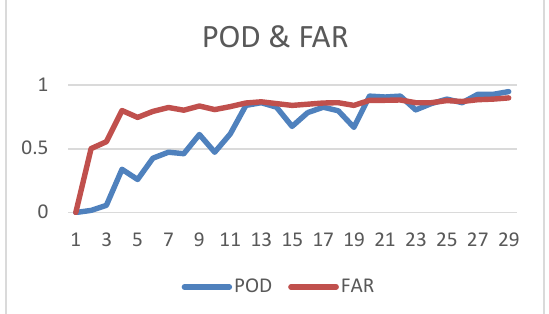
Figure 7. POD and FAR of all